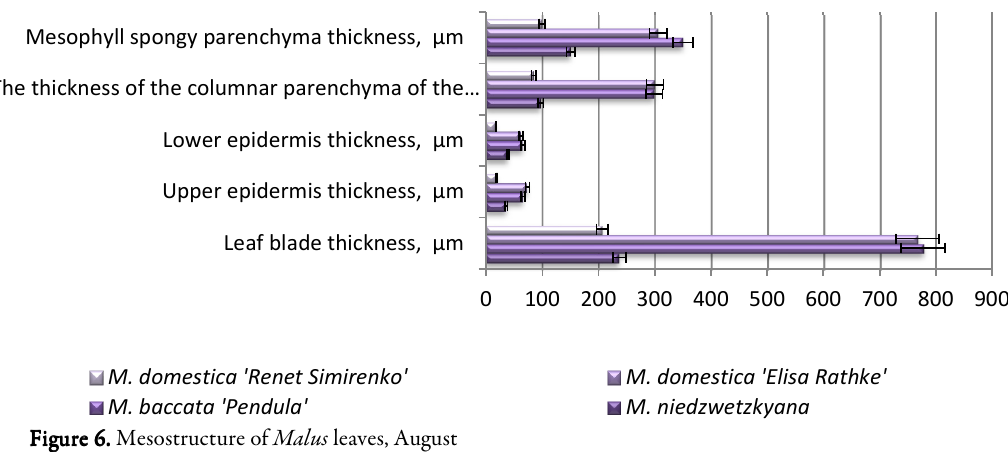
Figure 6. Mesostructure of Malus leaves,